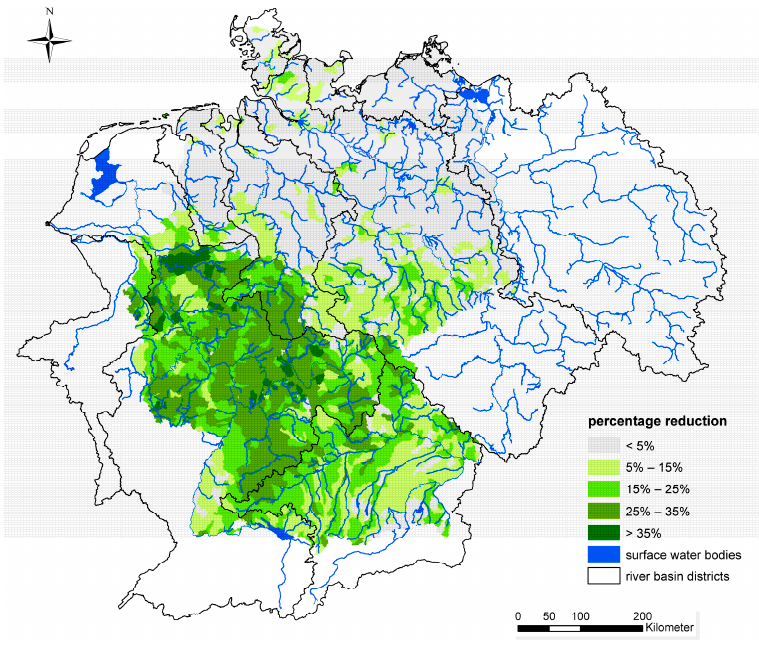
Figure 8. Spatial distribution of reduction potential of copper emissions via sewer systems by implementation of storm water filtration, based on the mean emissions of the years 2012–2014.